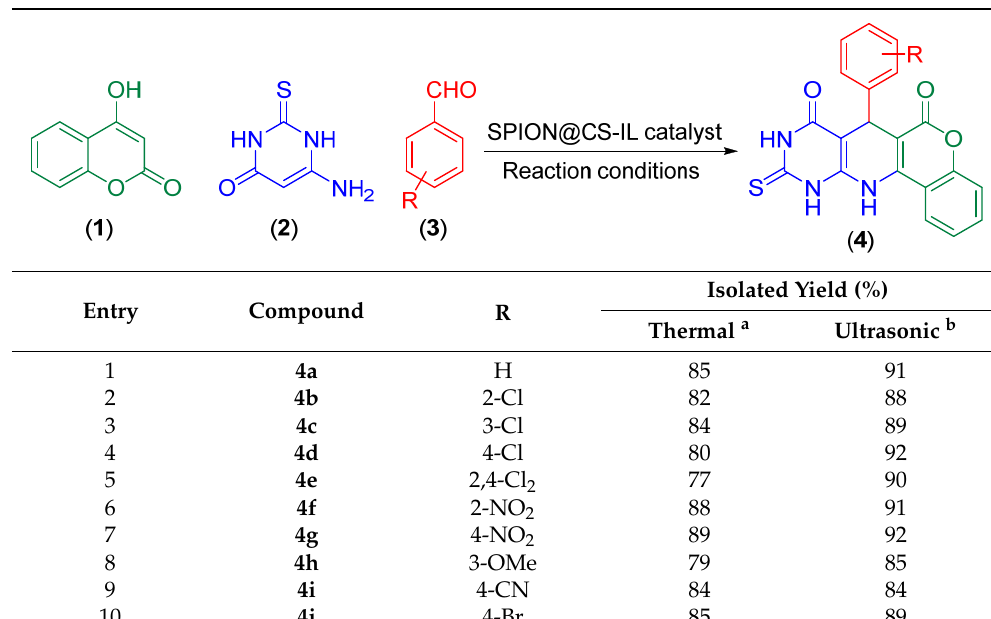
Table 2. SPION@CS-IL -catalyzed the synthesis of pyrido[2,3- d ] pyrimidine-dione derivatives. Table 2. SPION@CS − IL − catalyzed the synthesis of pyrido[2,3 − d ] pyrimidine − dione derivatives.